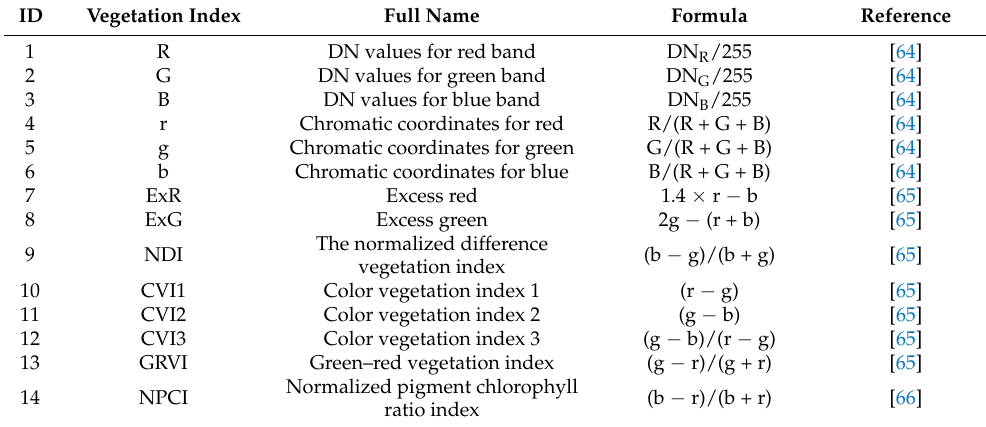
Table 4. Vegetation indices based on digital RGB